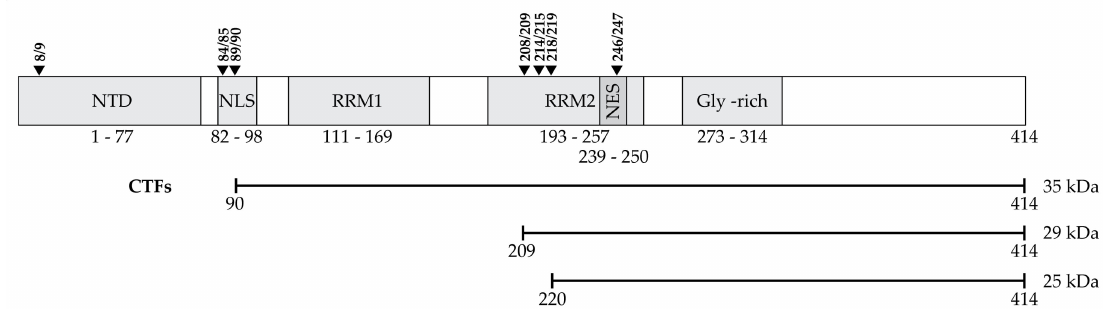
Figure 1. TDP-43 domain structure, potential caspase cleavage sites and CTFs. TDP-43 domain structure consists of an N-terminal domain (NTD), a nuclear localizing sequence (NLS), two RNA recognition motifs (RRM1 and RRM2), a glycine- rich domain and a nuclear export sequence (NES). Caspase-mediated cleavage sites are indicated with black triangles and can occur between amino acid residues 8/9, 84/85, 89/90, 208/209, 214/215, 218/219 and 246/247. The major CTFs that have been identified in patient tissues are indicated